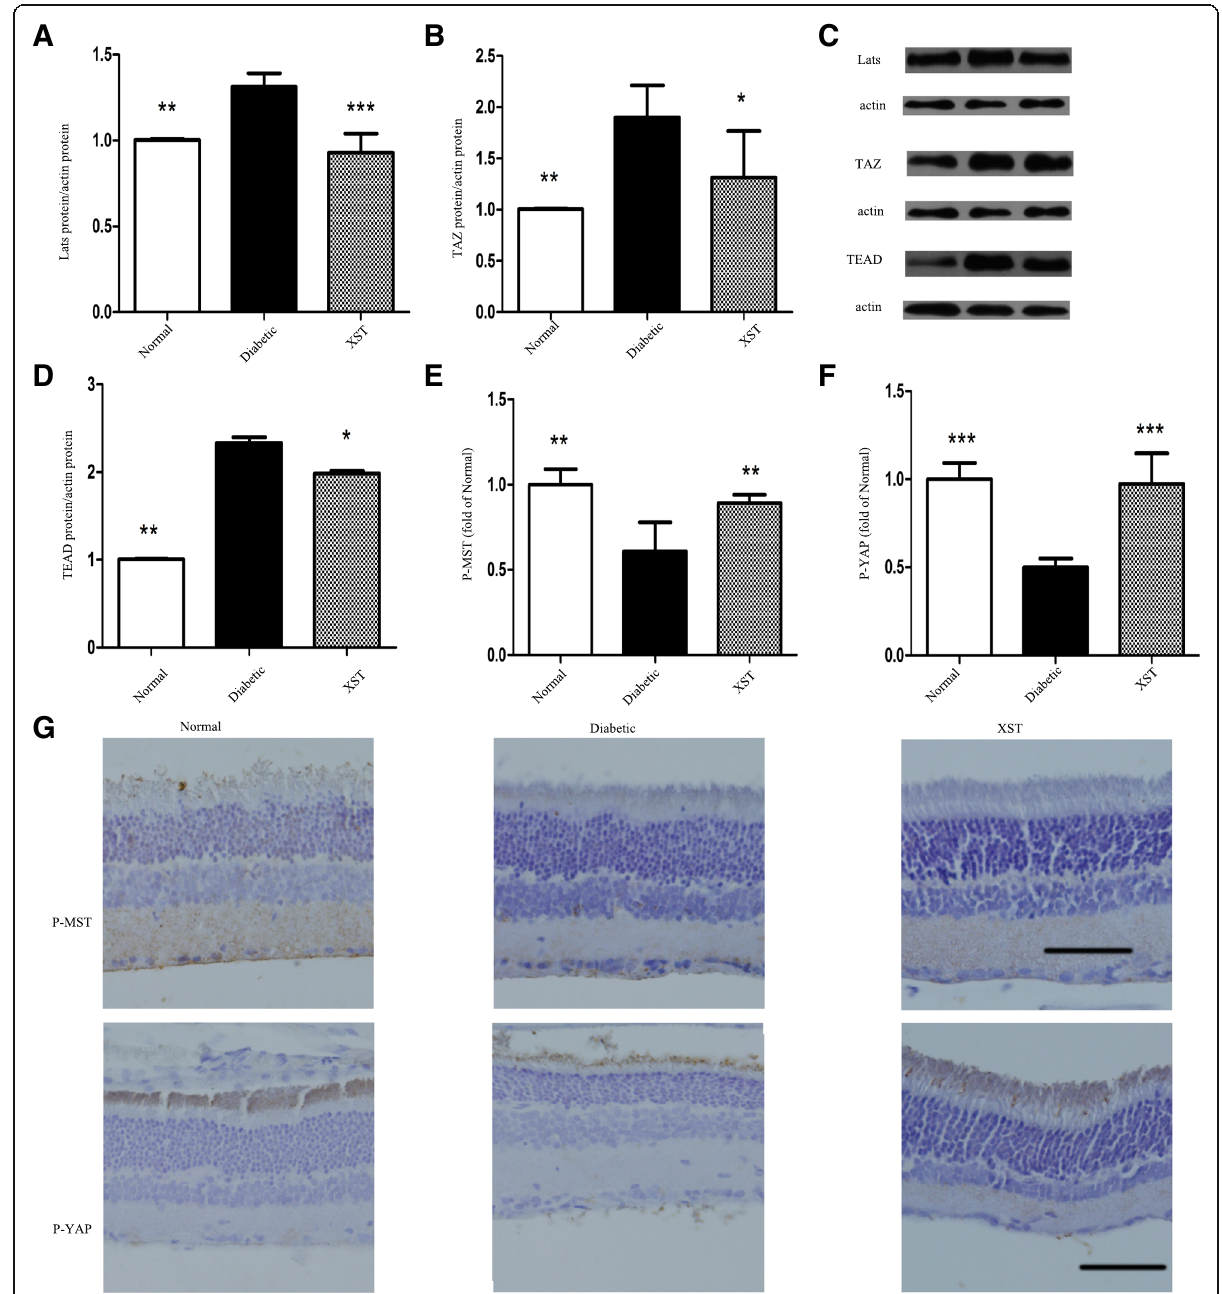
Fig. 4 The effect of XST on protein levels of Hippo pathway. a – d the protein levels of Lats, TAZ and TEAD were evaluated by WB. XST decreased levels of Lats, TAZ and TEAD protein. e – g Distribution and expression of P-MST and P-YAP were measured using IHC. P-MST was mainly observed in inner plexiform layer and small amount was expressed in outer nuclear layer and photoreceptor layer. P-YAP was clearly seen photoreceptor layer. An elevation of P-MST and P-YAP were observed in XST group. Data were represented as mean ± S.D. ( n = 3 – 4).*: P < 0.05, **: P < 0.01, ***: P < 0.001, compared to